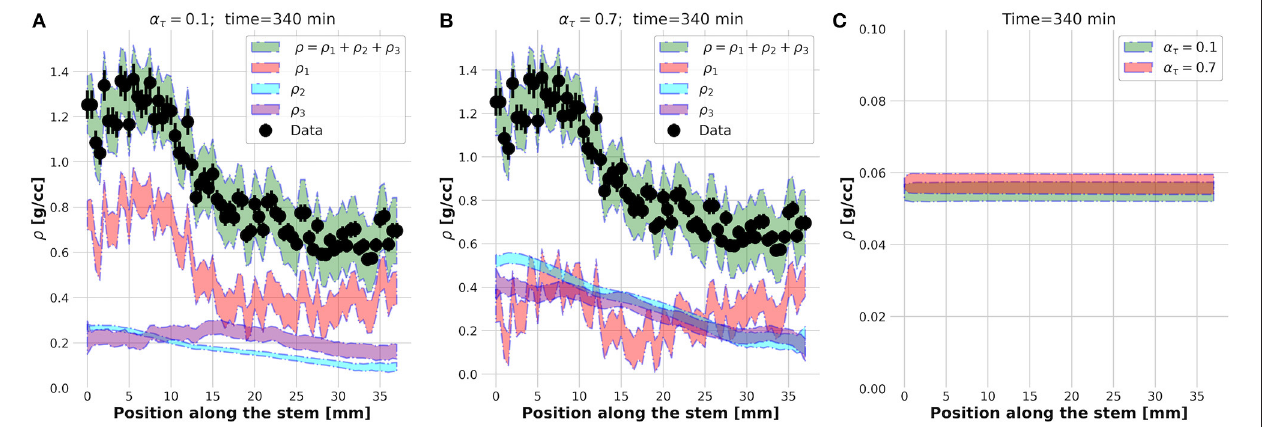
FIGURE 6 | Estimated spatial profiles of the ρ 1 , ρ 2 , and ρ 3 components of the tracer density ρ at time t = 340 s for α τ = 0.1 (A) and α τ = 0.7 (B) . Velocity profile at t = 340 s (C)